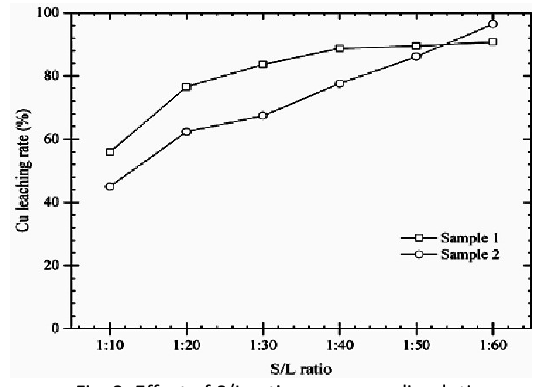
Fig. 2. Effect of S/L ratio on copper dissolution